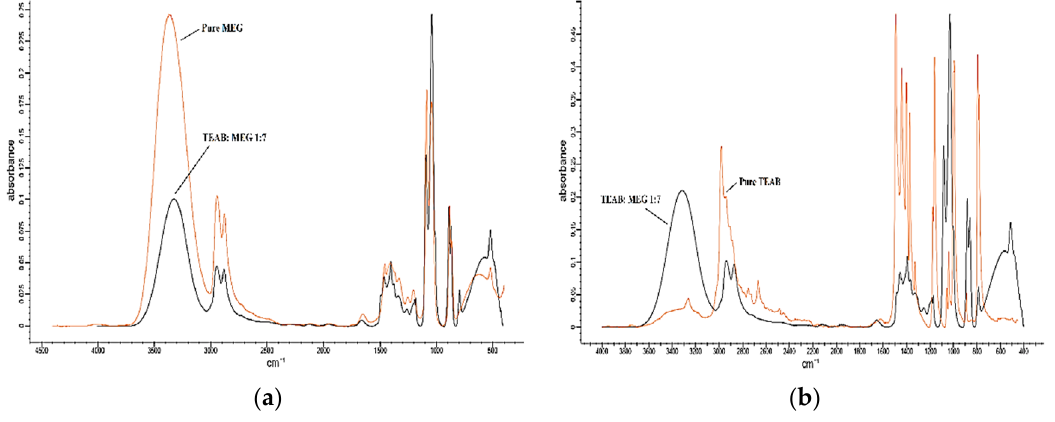
Figure 5. The FTIR comparison of TEAB:Glycerol with ( a ) pure Glycerol and ( b ) pure TEAB. TEAB, Tetraethylammonium Bromide.